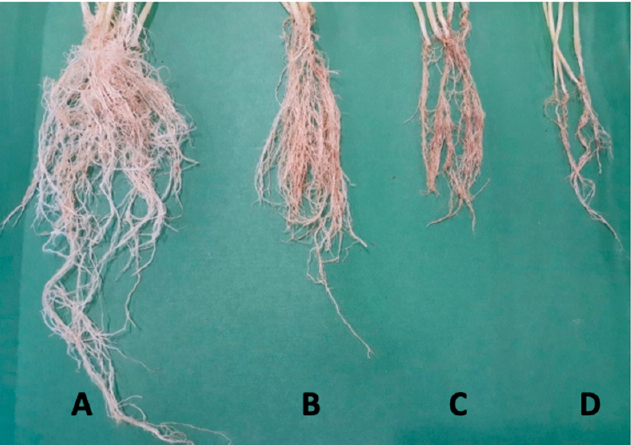
Figure 9. The effect of S. fulvissimus Uts22 strain and its microcapsules on increasing the root in cucumber plants: ( A ) S. fulvissimus Uts22 microcapsules; ( B ) S. fulvissimus Uts22 bacteria; ( C ) control; ( D ) P. aphanidermatum .